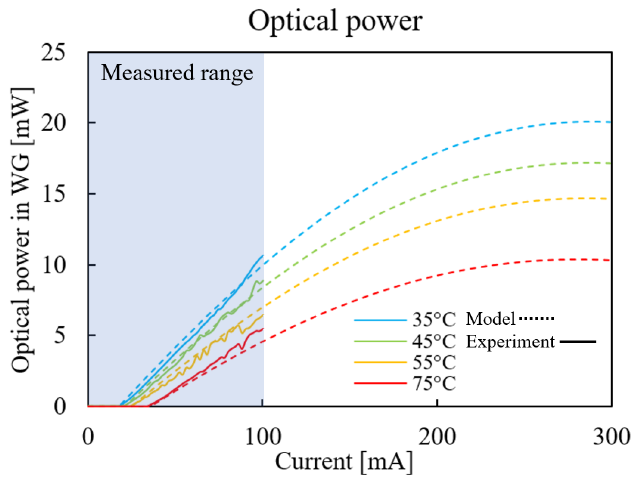
Figure 4. Laser L–I characteristic and model